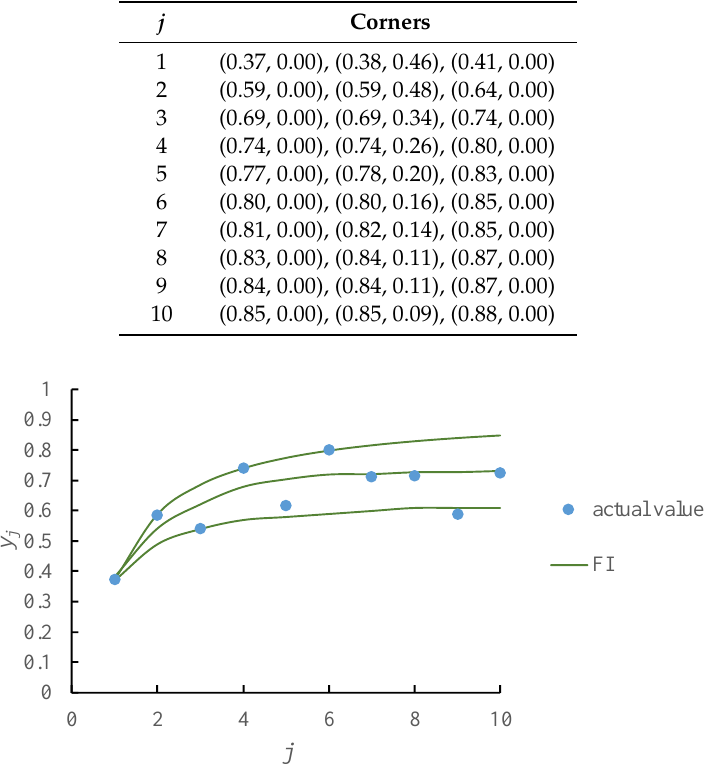
Figure 11. Chen and Lin method results based on overall consensus. Table 5. Forecasting performances for Chen and Lin method if experts did not collaborate.